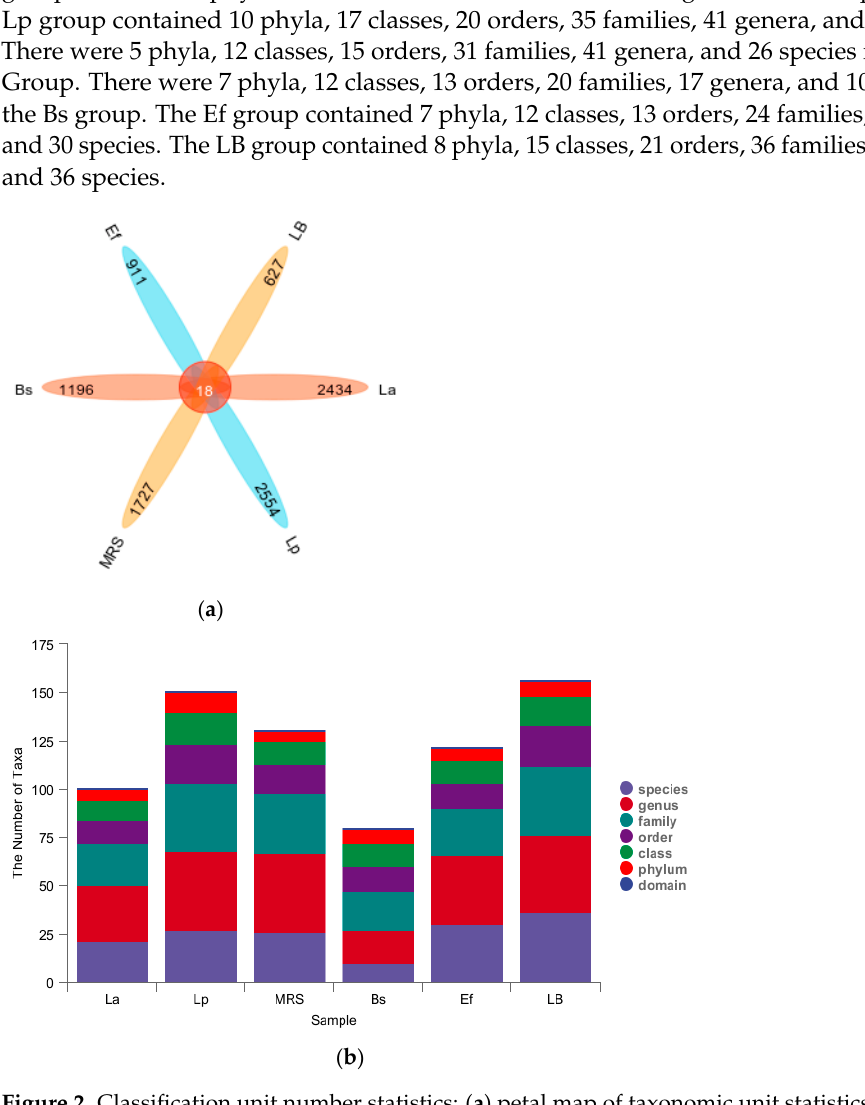
Figure 1. Sequence–length distribution: The abscissa is the number of sequences, and the ordinate is the length of the sequence.